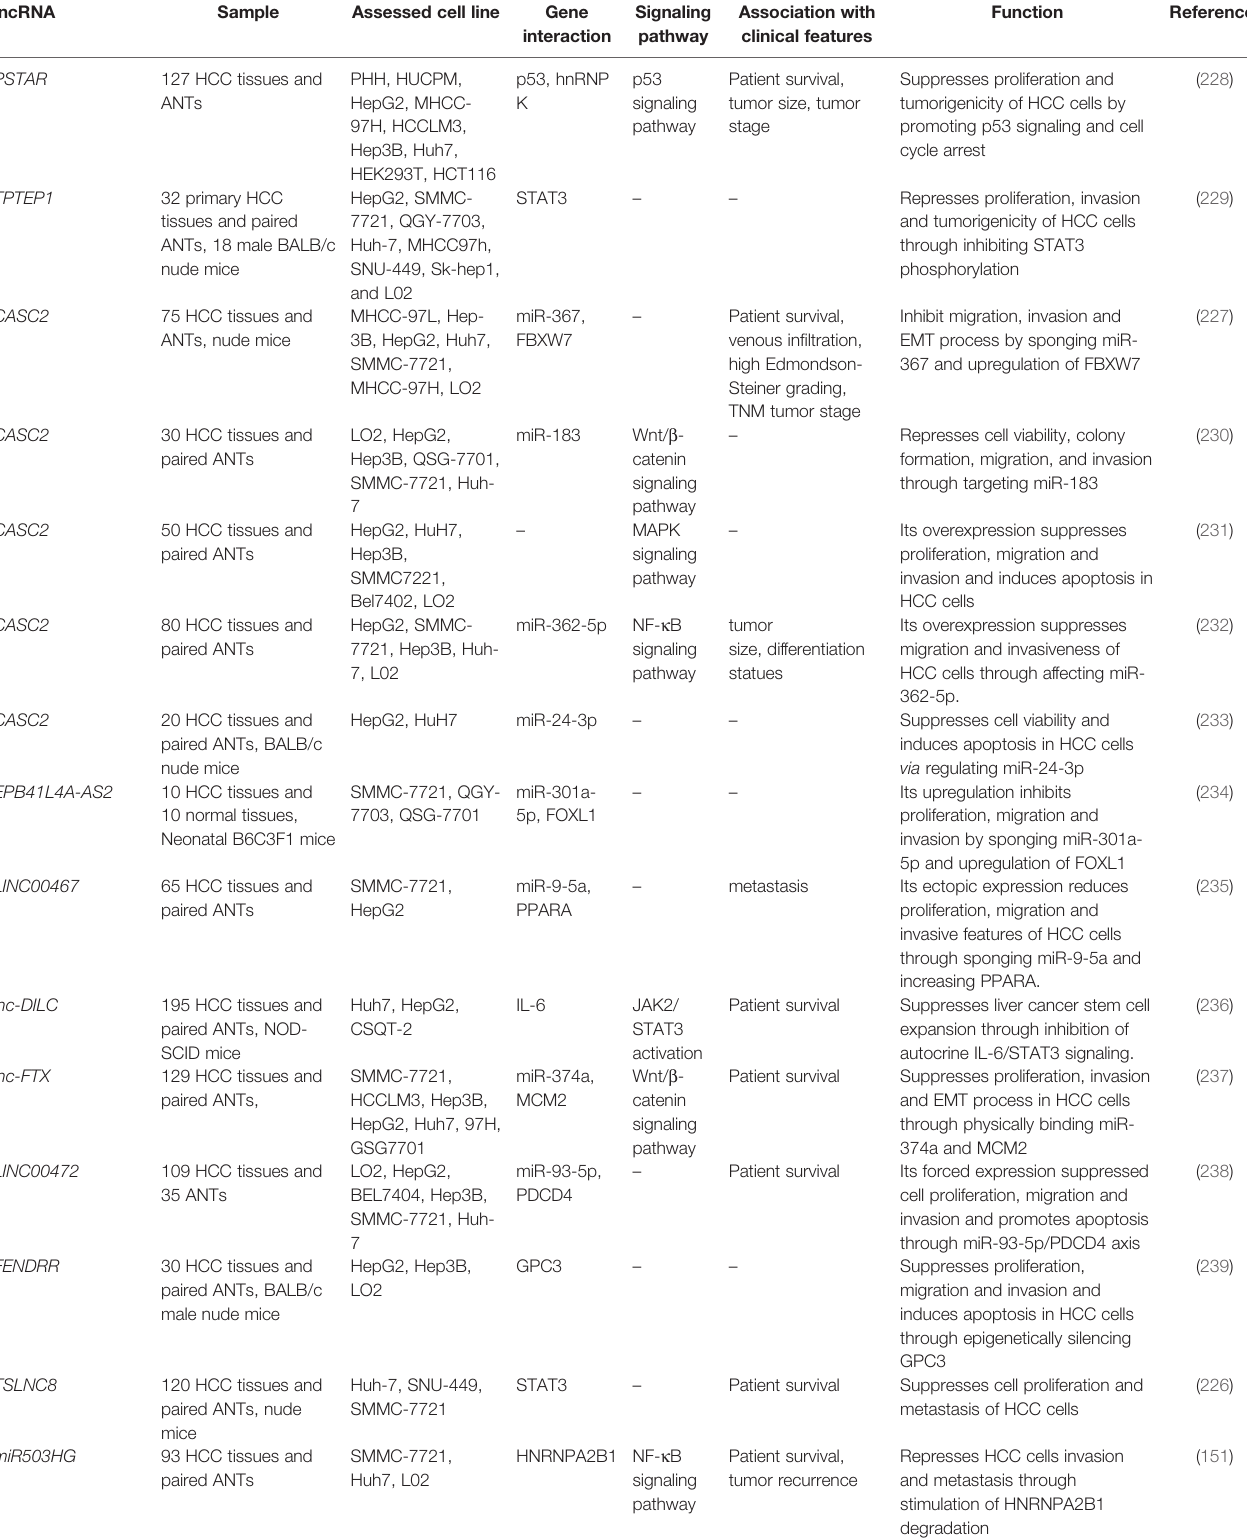
TABLE 2 | List of under-expressed lncRNAs in HCC (ANT, adjacent non-cancerous tissue).